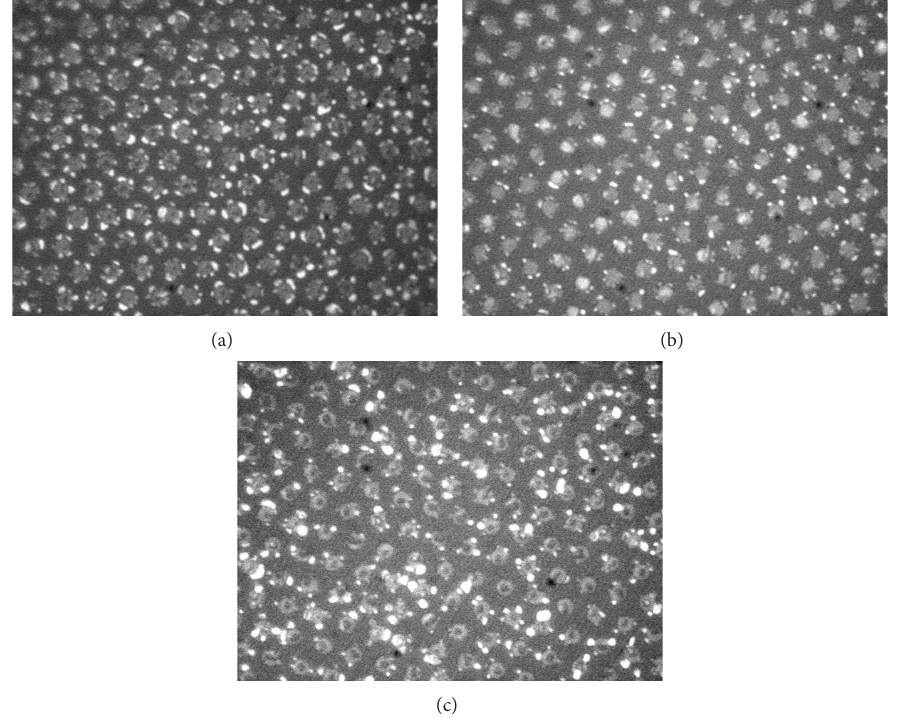
Figure 7: The OM images of (a) sample-R, (b) sample-T, and (c)